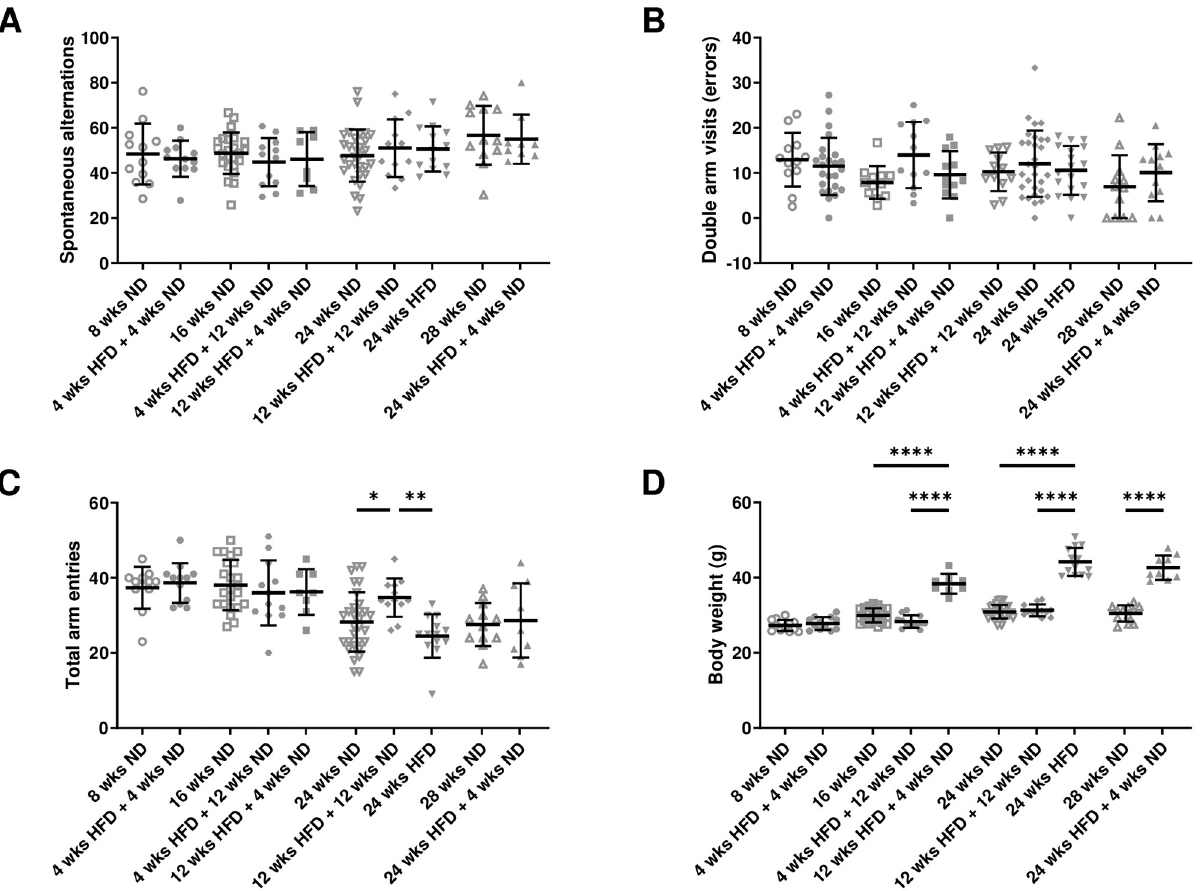
Fig 3. HFD has no effect on short-term memory in the Y maze test. (A) Spontaneous alternations were not affected by diet/dietary change. (B) No difference in the number of double arm visits (errors) regarding diet/dietary change was found. (C) Analysis of total arm entries revealed a significant effect of diet. (D) Mice gained more weight after longer HFD or rather lose weight after dietary change from HFD to ND. Data are presented as mean values and error bars indicate SD; 8 wks ND n = 11, 16 wks ND n = 24, 24 wks ND n = 30, 28 wks ND n = 12, 4 wks HFD + 4 wks ND n = 12, 12 wks